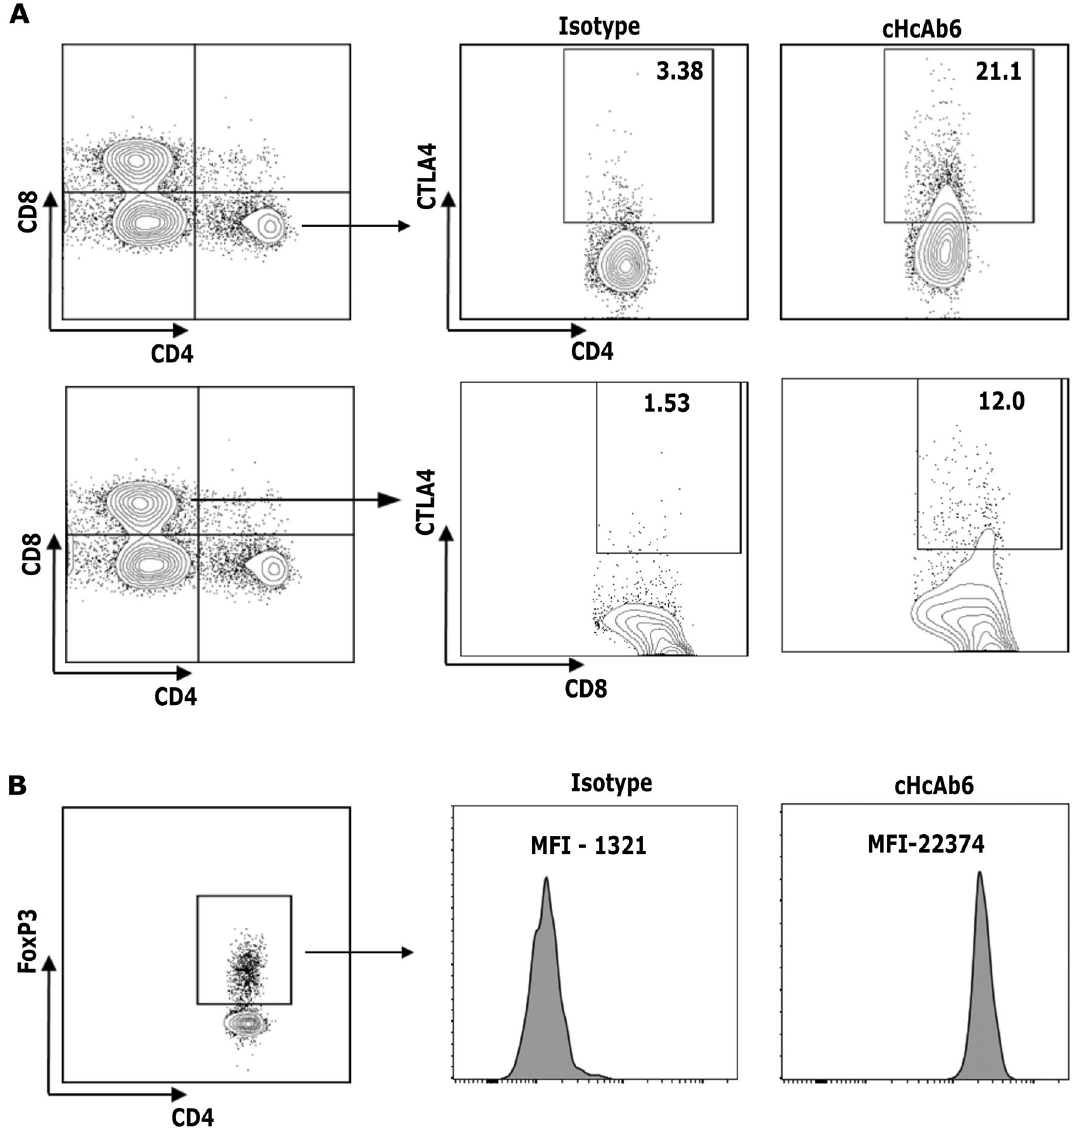
Figure 4. Canine Tregs constitutively express CTLA4. Activated cPBMCs were first stained with cHcAb6. The cHcAb6 stained PBMCs were fixed, permeabilized, and treated with anti-CD3, CD4, CD8, and FoxP3 antibodies. The bound cHcAb6 was detected using anti-canine IgG Fc-750 Ab. Canine IgG was used as an isotype control. ( A ) The CTLA4 was predominantly expressed on helper T cells and a small subset of cytotoxic T cells. ( B ) CTLA4 was constitutively expressed on Tregs. MFI Mean fluorescence